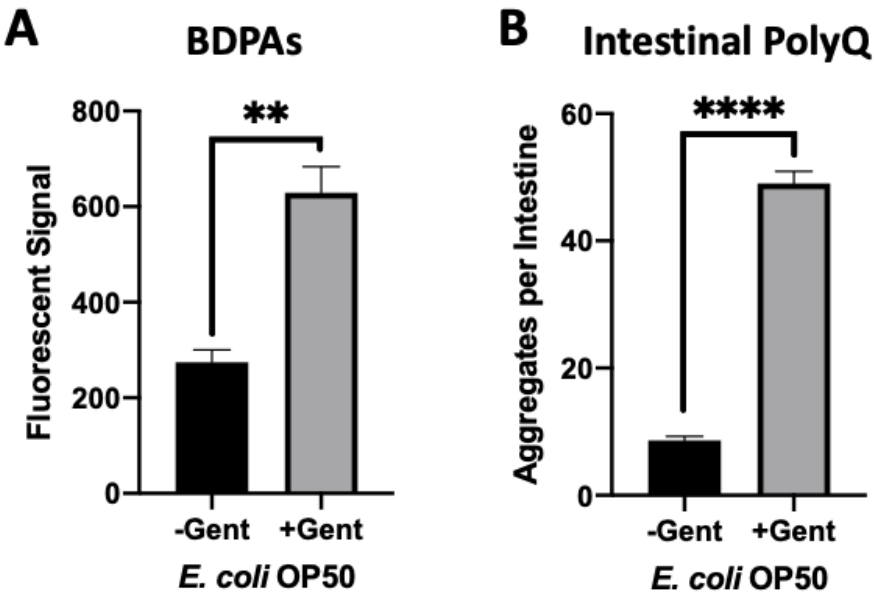
Figure 5. Gentamicin-induced disruption of bacterial proteostasis increases polyQ aggregation in the C. elegans intestine. ( A ) ProteoStat assay quantification of total protein aggregates produced by E. coli OP50 in liquid culture in the absence (-Gent) or presence (+Gent) of 1 µ g/mL gentamicin, a non-effective concentration (Figure S2A). Data are represented as the average ProteoStat fluorescent signal per bacterial strain per treatment. Each data point is an average of two independent experiments with three internal replicates per run. ( B ) Intestinal polyQ aggregation in C. elegans colonized with E. coli OP50 in the absence (-Gent) or presence (+Gent) of 200 µ g/mL, a sub-lethal concentration (Figure S2B). Data are represented as the average number of polyQ aggregates per C. elegans intes- tine. Each data point is an average of three independent experiments with a minimum of 90 worms. A-B) Error bars represent SEM. Statistical significance was calculated using Student’s t -test (** p < 0.01, **** p < 0.0001).